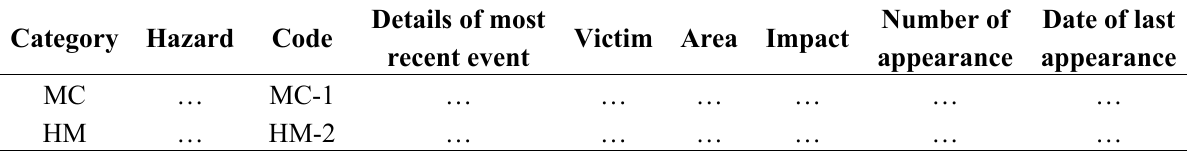
Table 4. Proposed structure for the monitoring and logging of hazards in the